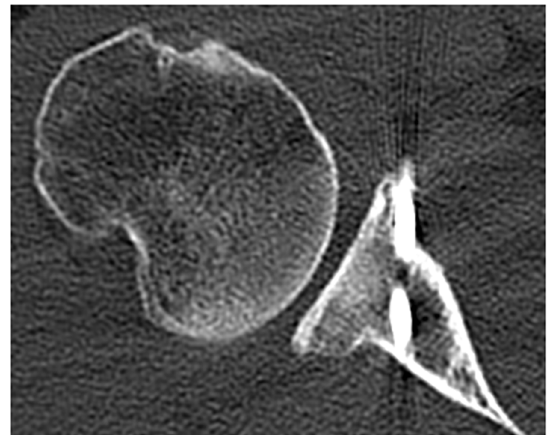
Fig. 3 Postoperative CT-scan of a patient with a large and medial Hill-Sachs lesion that was not fully restored with the Latarjet